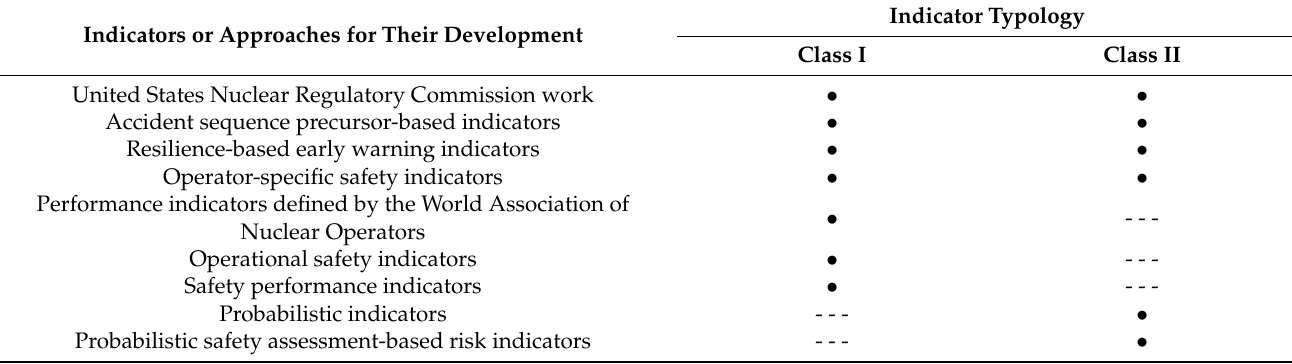
Table 4. Examples of indicators Class I and II or approaches for their development (Adapted from [5]). Indicators or Approaches for Their